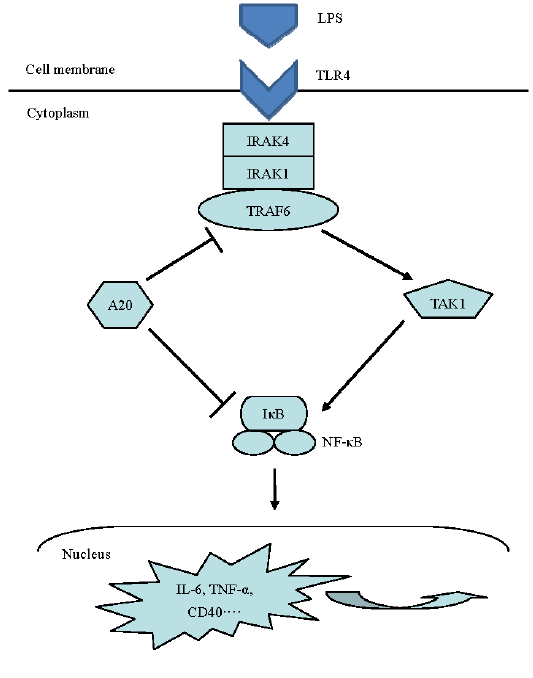
Figure 7. Effects of A20 on LPS signaling pathway. A20 depress the inflammatory response induced by LPS through negatively regulated the relevant function of adaptors in LPS signaling